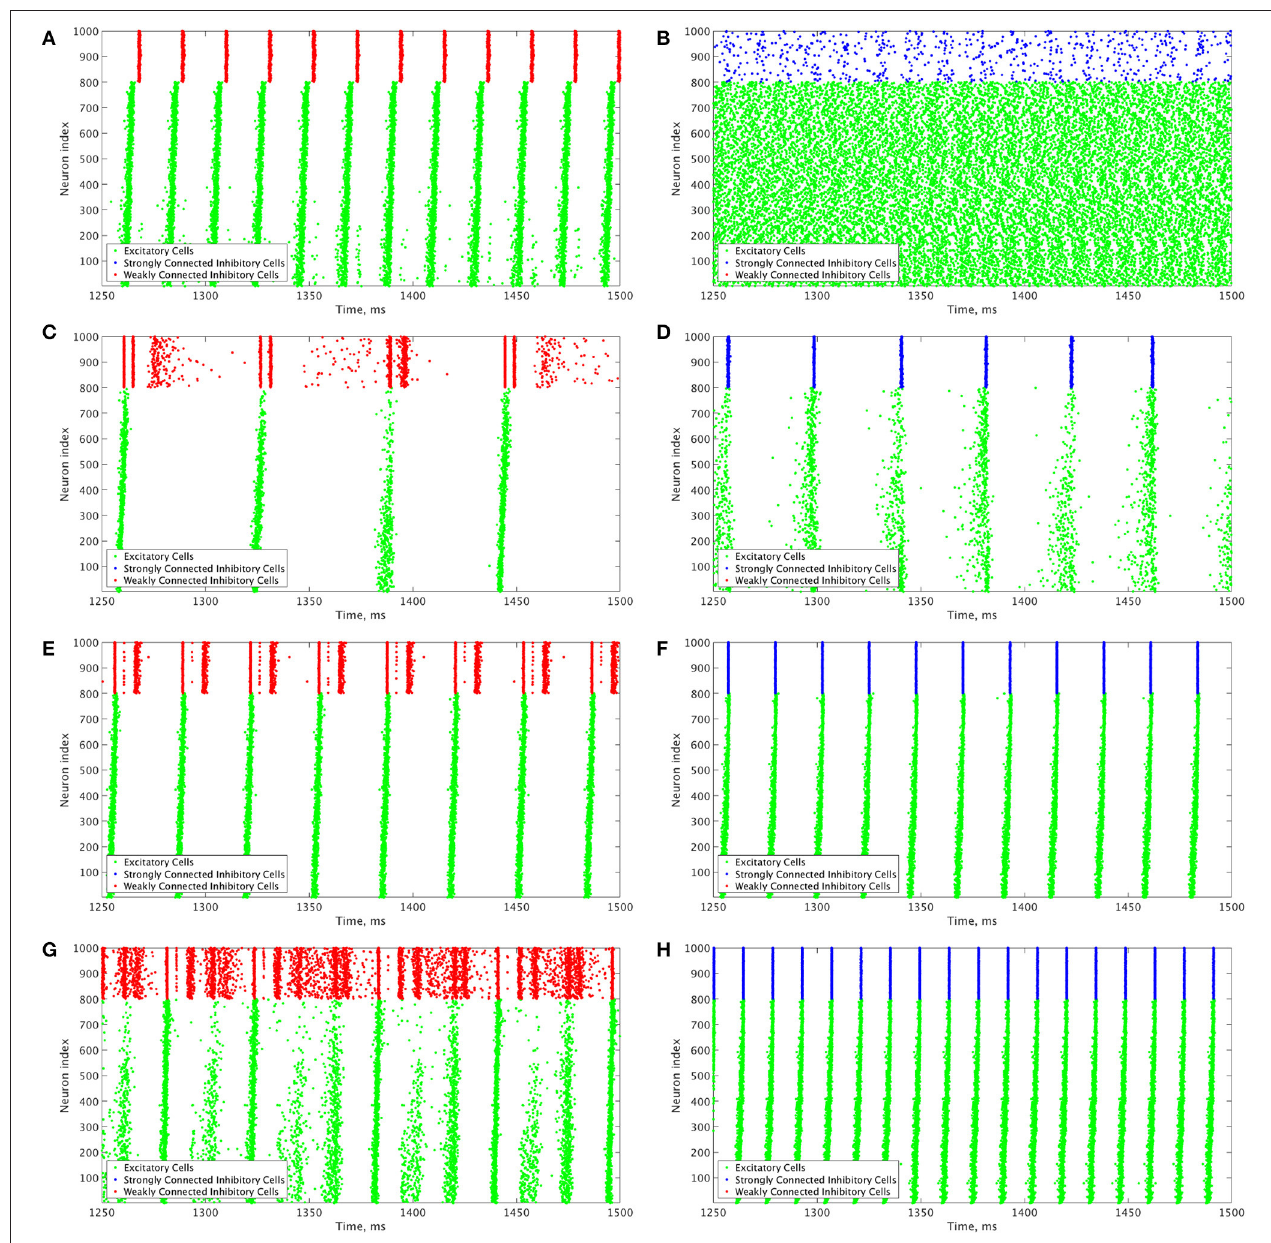
FIGURE 3 | Example raster plots illustrate the differences between dynamics in networks with weakly connected and strongly connected inhibitory subnetworks. (A–H) Example raster plots with the excitatory cells (green dots) in these raster plots organized such that cells with the highest external drive are given the lowest Neuron Indices with the rest of the neurons organized such that decreasing external drive corresponds with increased Neuron Index. Panel letter corresponds with overlaid labels in Figures 4 , 5 indicating the parameters of the given network. (A,C,E,G) are from networks with weakly connected inhibitory subnetworks, while (B,D,F,H) are from networks with strongly connected inhibitory networks. (A,B) are raster plots from a network with an E-I synaptic weight of 0.0004 mS/cm 2 and an average intrinsic excitatory cell firing frequency of 98.8 Hz. (C,D) Are raster plots from a network with an E-I synaptic weight of 0.00235 mS/cm 2 and an average intrinsic excitatory cell firing frequency of 39.6 Hz. (E,F) are raster plots from a network with an E-I synaptic weight of 0.00235 mS/cm 2 and an average intrinsic excitatory cell firing frequency of 80 Hz. (G,H) are raster plots from a network with an E-I synaptic weight of 0.00235 mS/cm 2 and an average intrinsic excitatory cell firing frequency of 126 Hz.